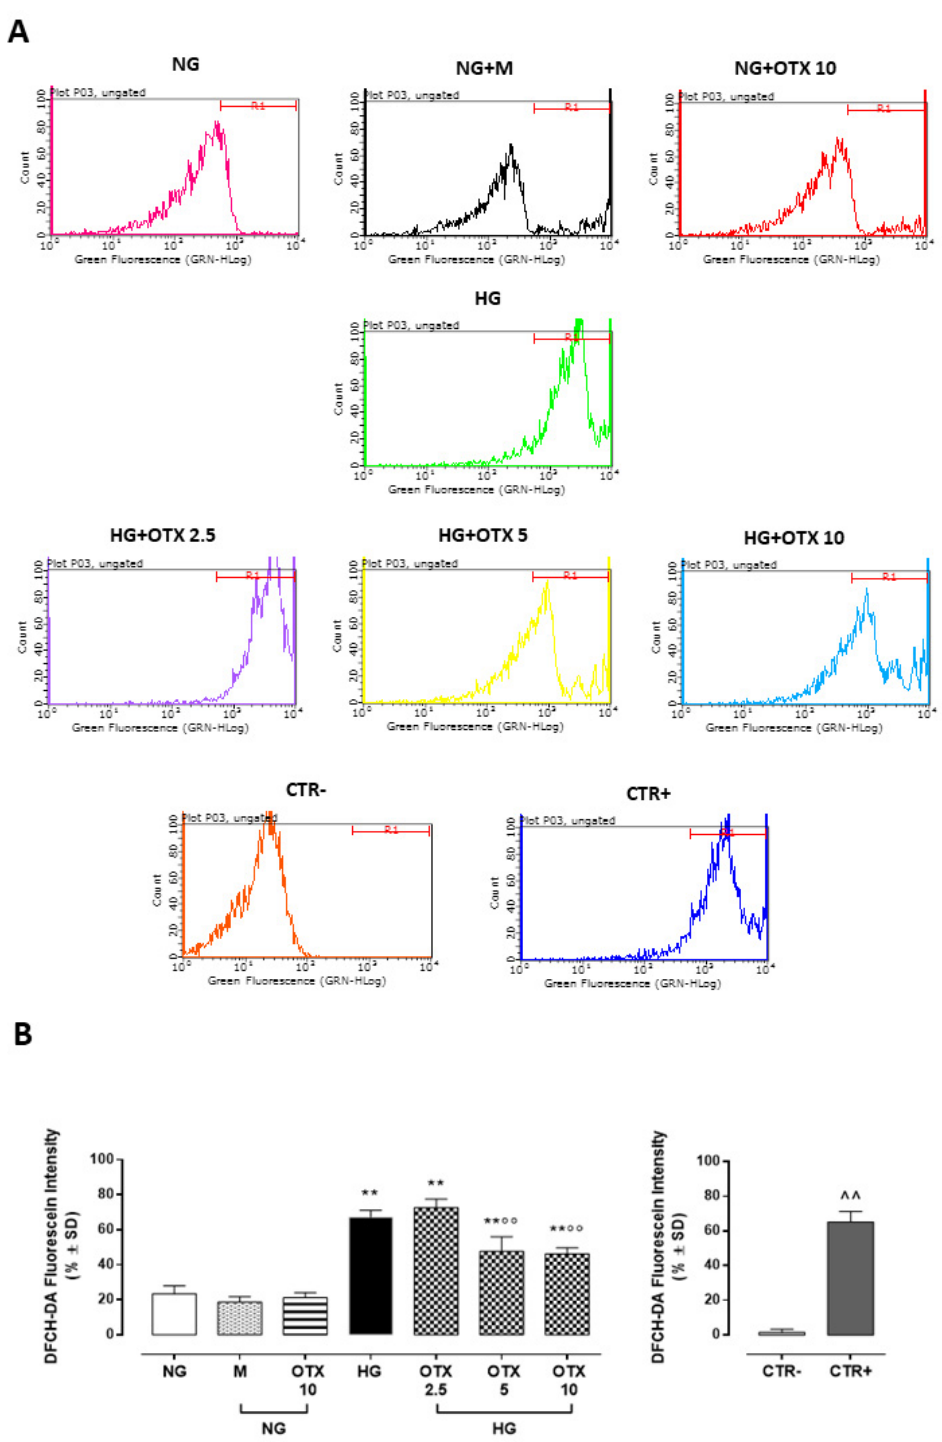
Figure 6. ROS production in ARPE-19 cells. ( A ) Total intracellular ROS levels assayed with 2 ′ ,7 ′ -dichlorodihydrofluorescein diacetate (DCFH-DA) probe and measured with a fluorometric plate reader (excitation = 485 nm; emission = 530 nm). ( B ) DCFH-DA levels, reported as percentage of fluorescein intensity ± SD of 9 observations per group (three independent experiments, each performed in triplicate). R1 region = DCFH-DA-positive cells. ** p < 0.01 vs. NG; ◦◦ p < 0.01 vs. HG; ˆˆ p < 0.01 vs. CTR–; NG, normal glucose (5 mM) + vehicle; M, mannitol (30 mM); HG, high glucose (35 mM) + vehicle OTX 2.5, OTX 2.5 µ M; OTX 5, OTX 5 µ M; OTX 10, OTX 10 µ M; CTR–, negative control (5% FBS without DCFH-DA); CTR+, positive control (H 2 O 2 100 µ M) used to gate R1